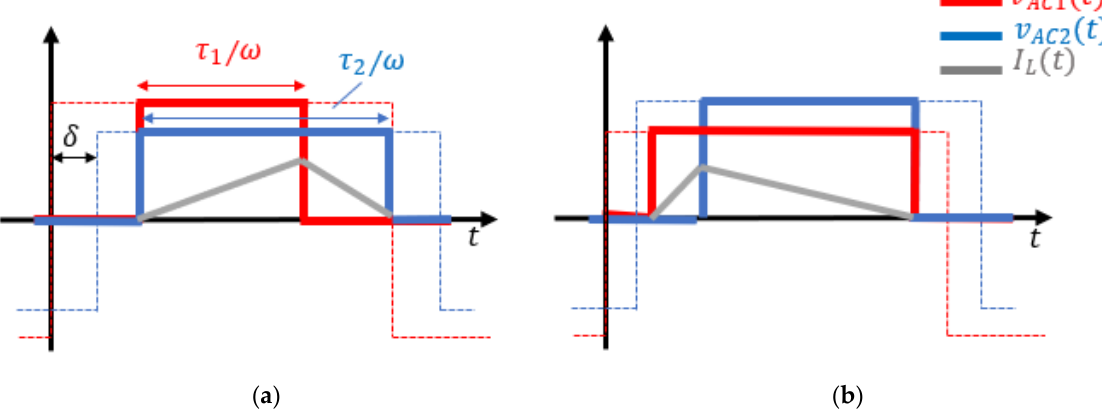
Figure 4. Voltage and current waveforms of half period for triangular modulation ( a ) buck mode, ( b ) boost mode.